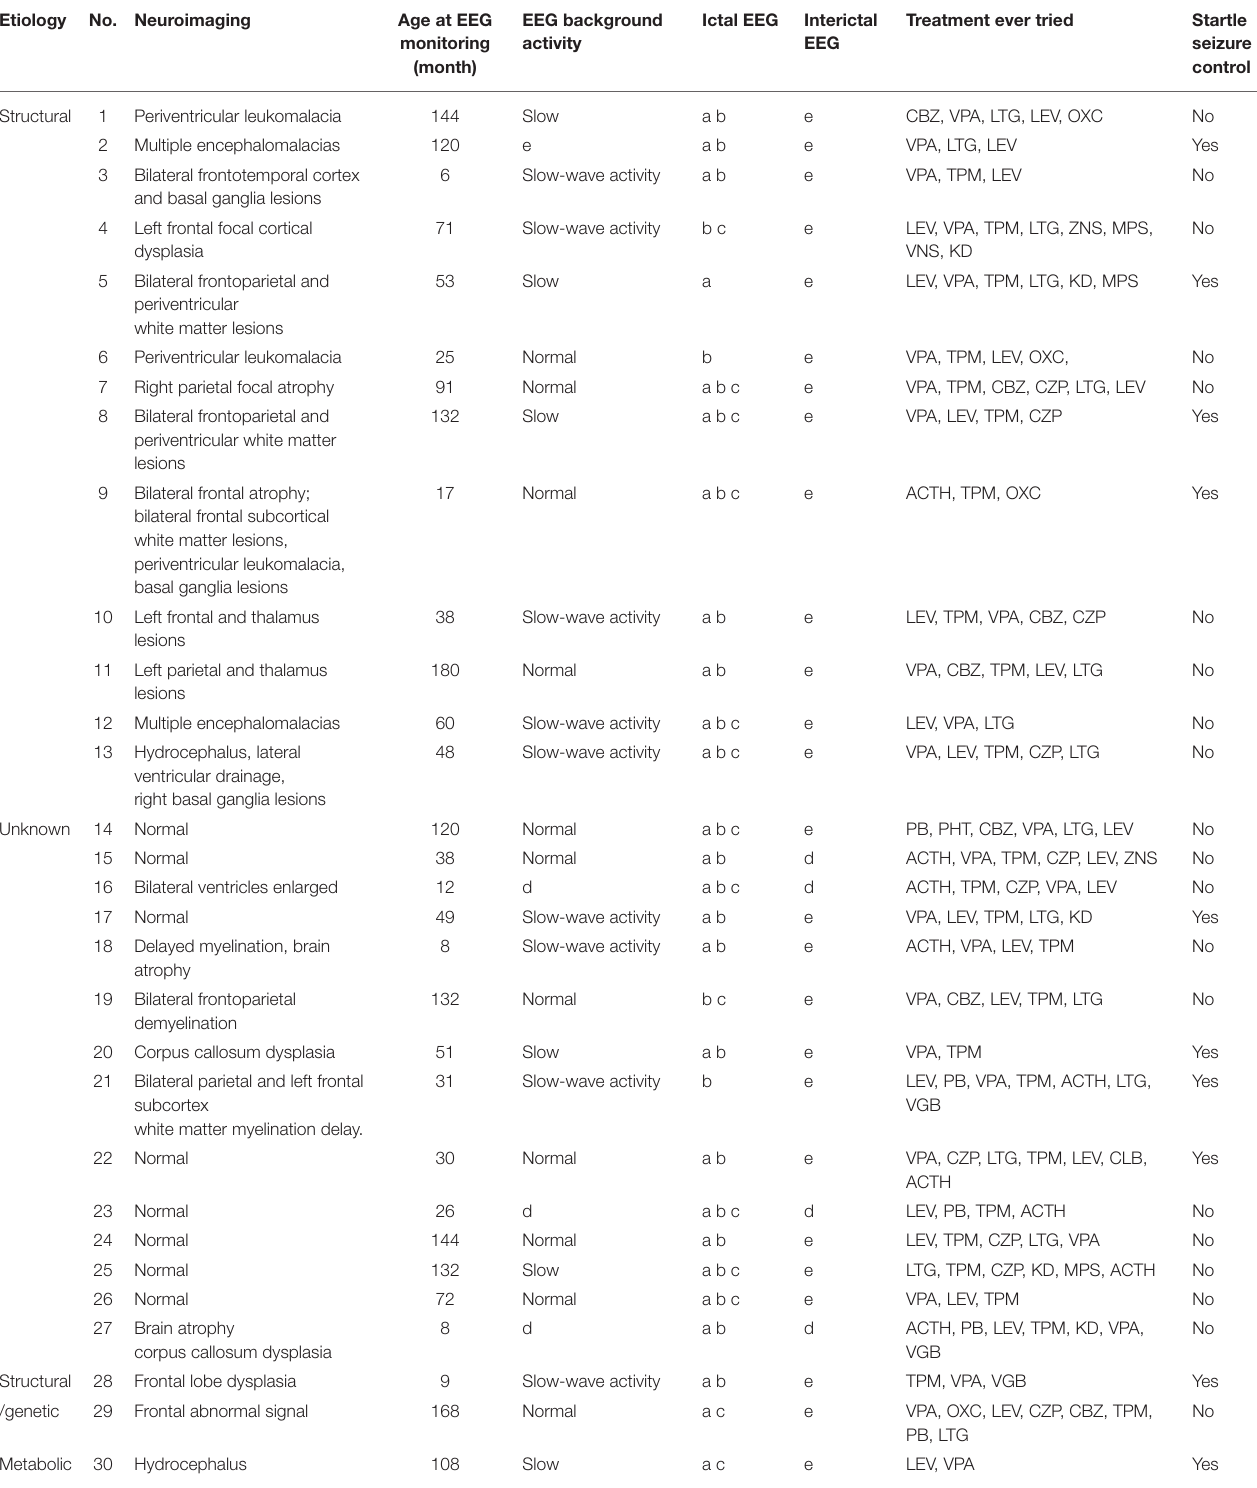
TABLE 2 | Clinical characteristics of patients. Etiology No. Neuroimaging Age at EEG